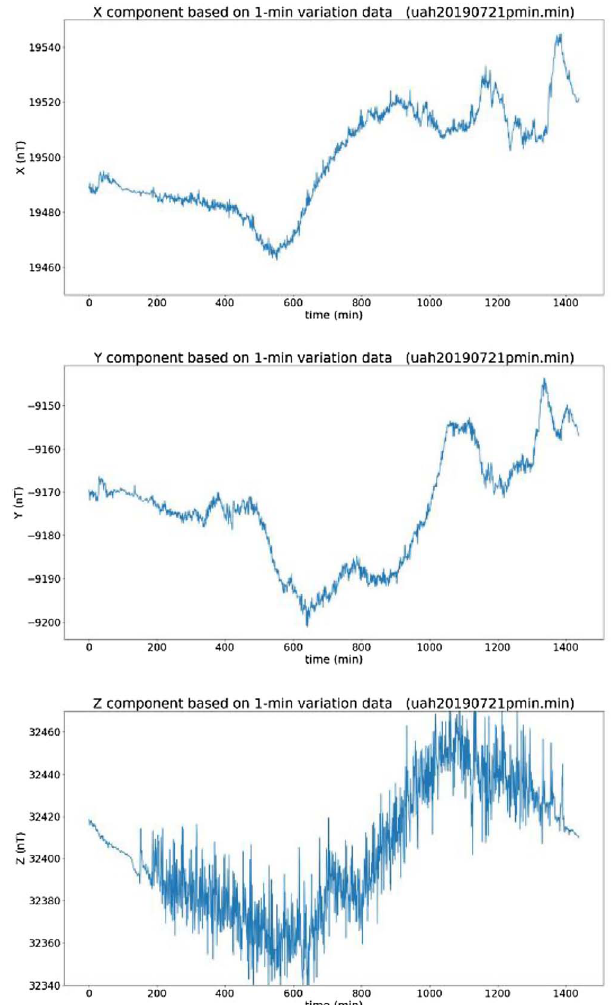
Fig. 5. An example of magnetometer recordings during a quiet day (27 July 2019). The three axes are shown from top to bottom, north ( X ), east ( Y ) and vertical ( Z )